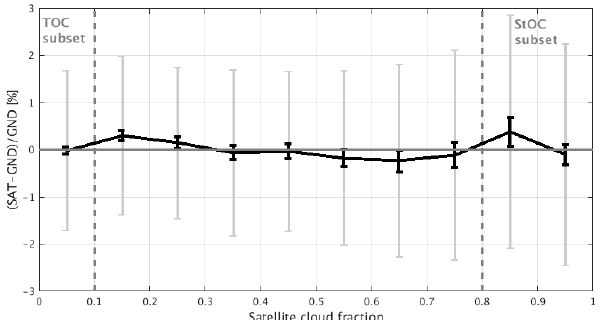
Figure 6. Dependence of TROPOMI total ozone column bias on the cloud fraction over the observed scene (TROPOMI L2_O3 OFFL V01.01.01–01.01.08). Comparisons are done over a 2-year period with respect to co-located total ozone column data from Brewer in- struments within the tropical belt. The curve is normalised (on a per-station basis) on the mean difference over the 0.2–0.6 CF range, in order to reduce the station-to-station scatter of the mean bias. The two dashed vertical lines identify the cloud-free and cloudy sub- sets used by the CCD algorithm. Error bars represent the standard deviation (grey) and twice the standard error of the mean (black) satellite-ground difference per CF